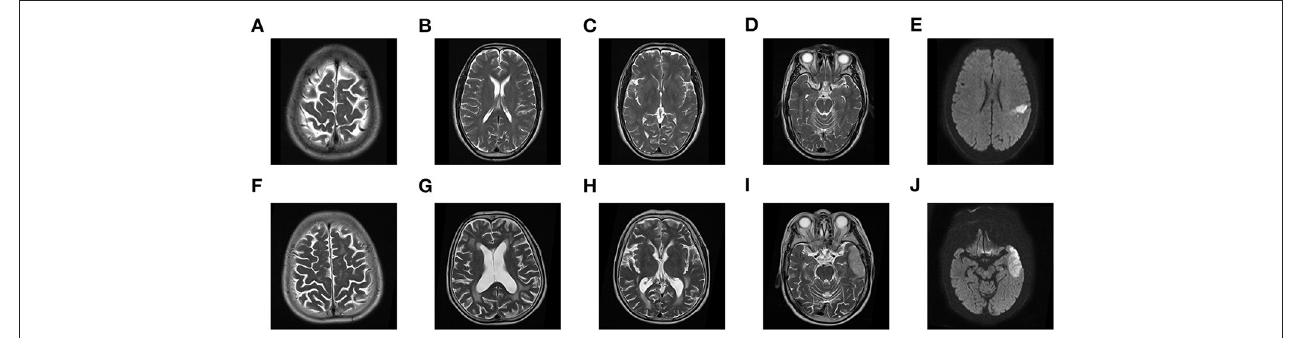
FIGURE 2 | MR features of brain atrophy and core infarct volume. (A) 68-year-old patient developed non-SAP and good functional outcome (MRS, 0 points) with brain atrophy 0 level (A–D) and core infarct volume 54.6 × 50ML (E) . A 70-year-old patient developed SAP and poor functional outcome (MRS, 5 points) with brain